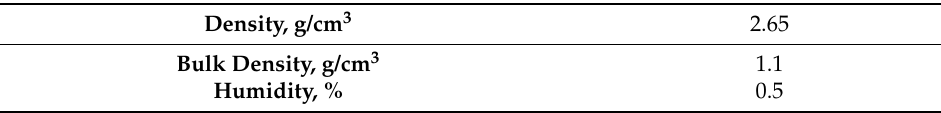
Table 5. Physical properties of FK-100 potassium